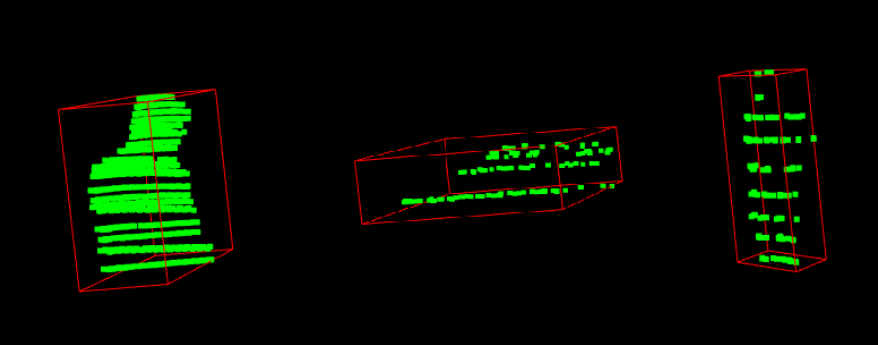
Figure 9. Display cluster segmentation results.